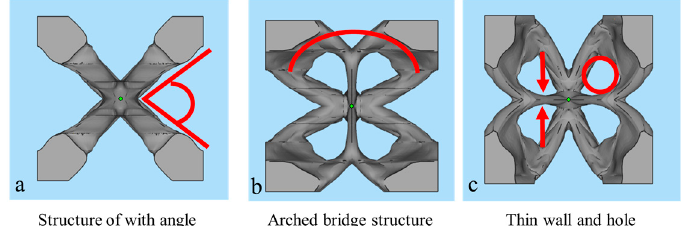
Figure 4. Abstracted typical structures from topology optimized geometries such as structures with angle ( a ); arched bridge structure ( b ); thin wall and small holes ( c ).